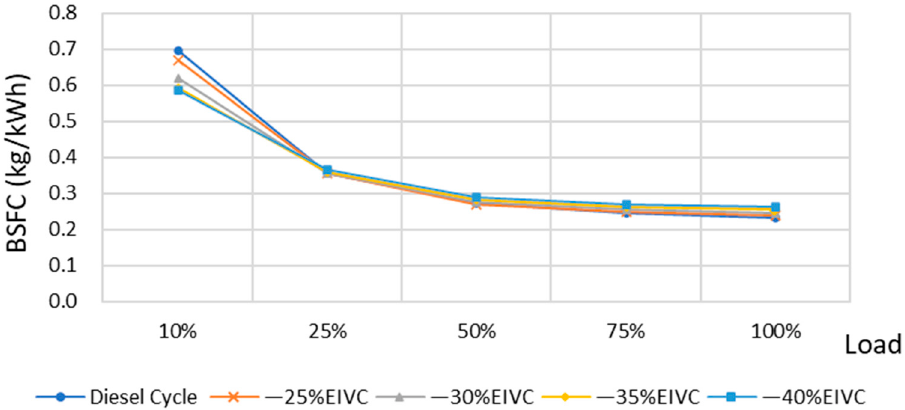
Figure 4. Comparison of BTEE under diesel engine EIVC Miller cycle.